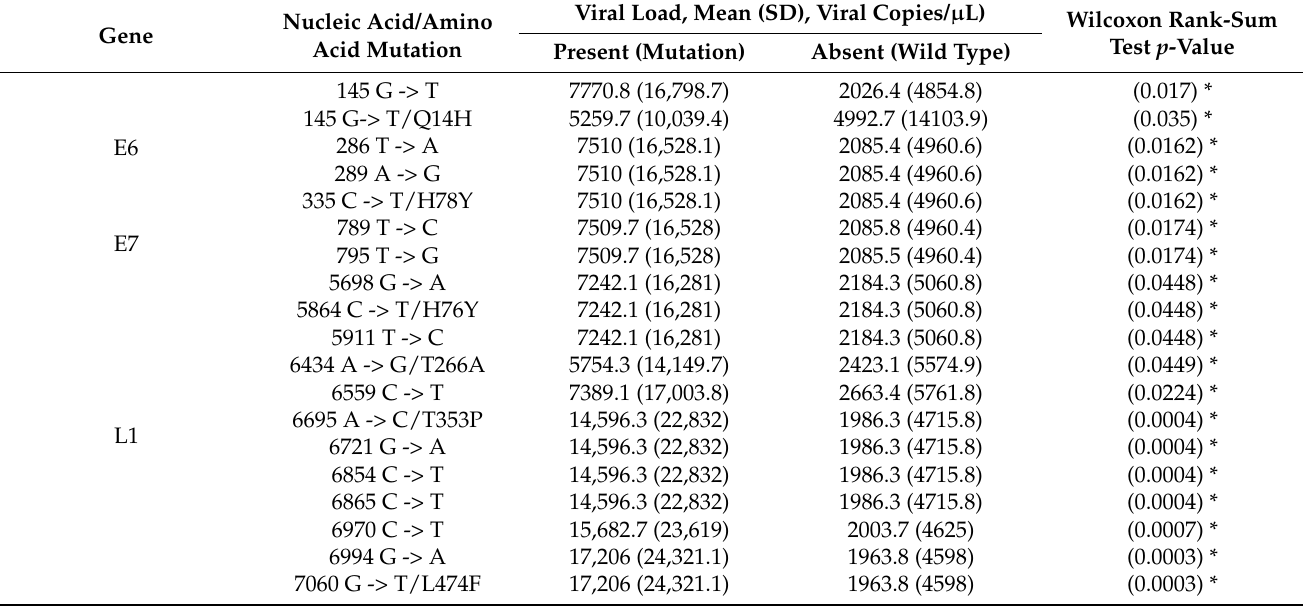
Table 7. HPV16 gene variants significantly associated with higher viral